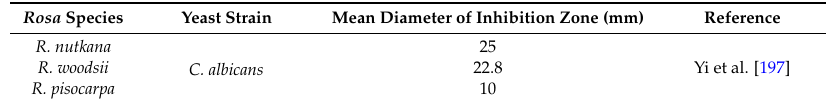
Table 6. Anti-mycotic effect of some Rosa species displayed as mean diameter of inhibition zone.